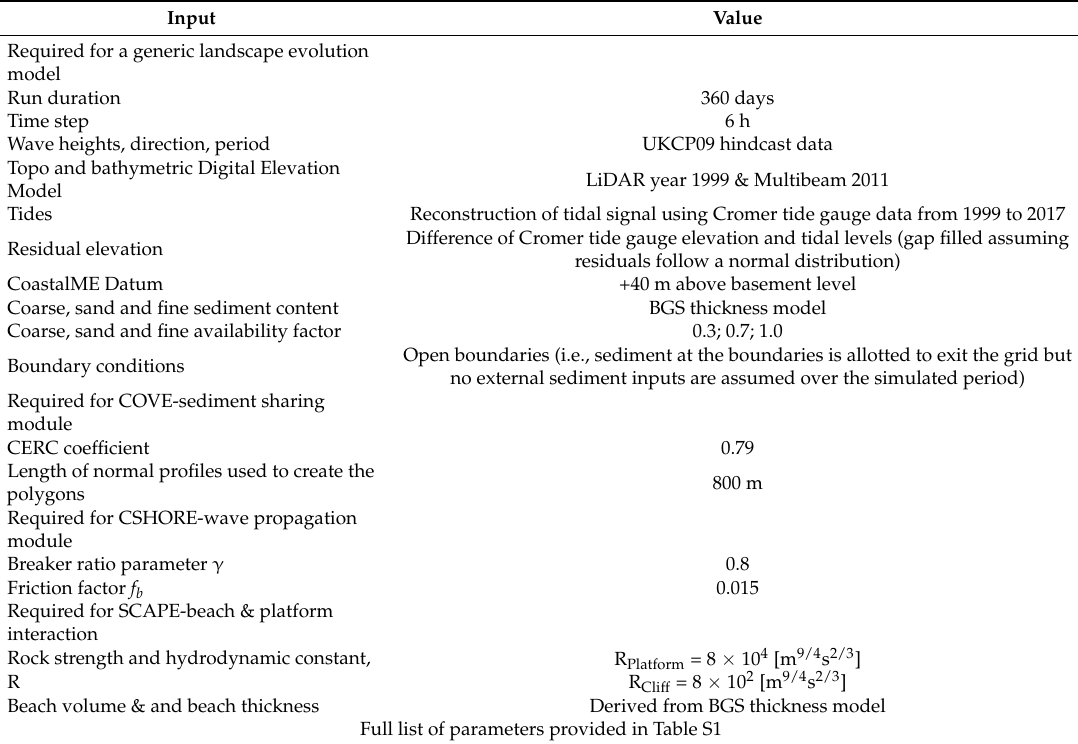
Table 2. CoastalME composition model